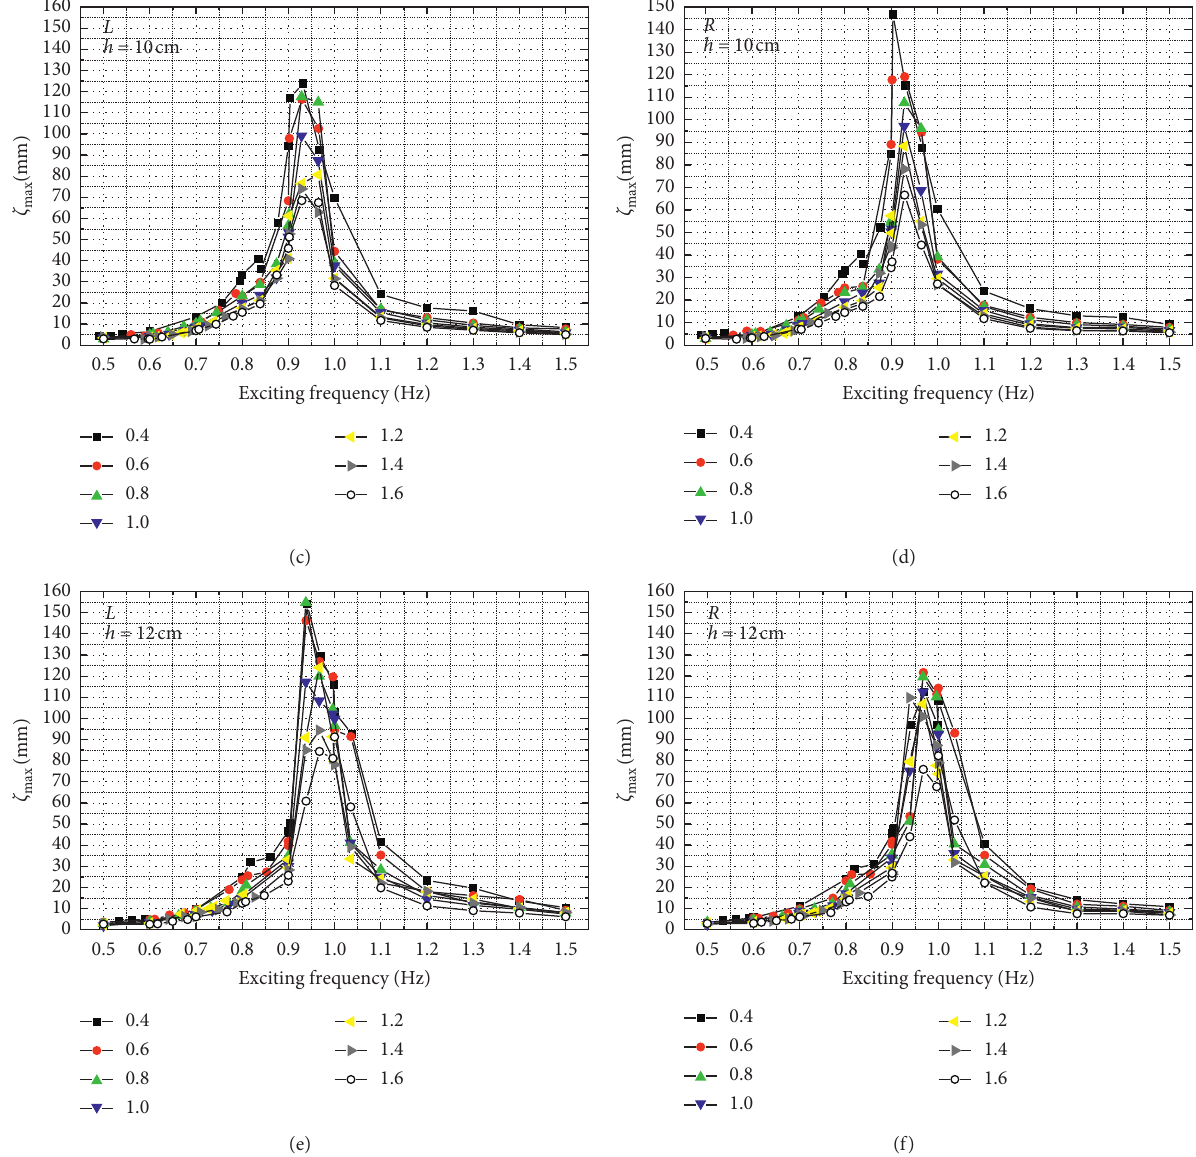
Figure 7: Maximum interfacial wave amplitude with various exciting frequencies. (a) Total liquid depth is 8cm, left wave altimeter. (b) Total liquid depth is 8cm, right wave altimeter. (c) Total liquid depth is 10 cm, left wave altimeter. (d) Total liquid depth is 10cm, right wave altimeter. (e) Total liquid depth is 12cm, left wave altimeter. (f) Total liquid depth is 12cm, right wave altimeter.